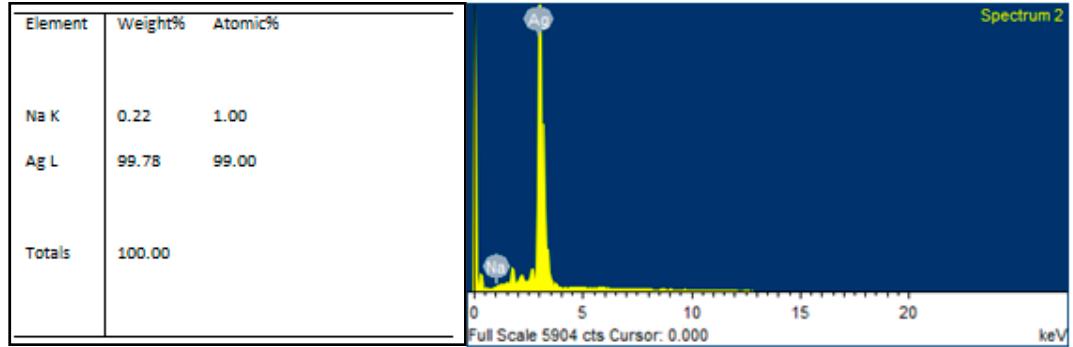
Figure 2. Energy Dispersive Spectroscopy (EDS) analysis of silver nanoparticles.